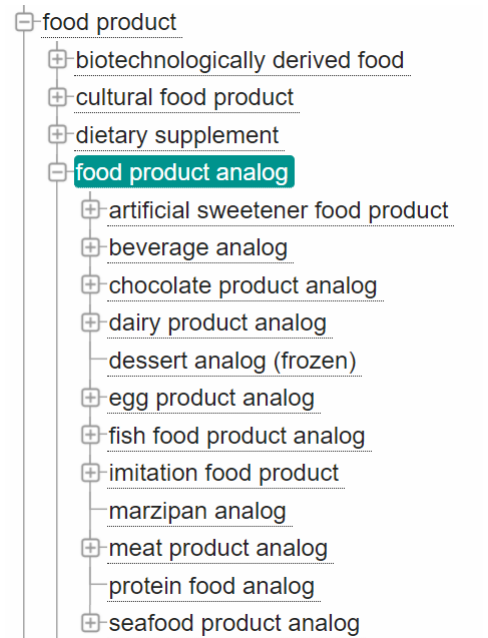
Figure 1. An excerpt from the FoodOn ontology with the subhierarchy of food analogs